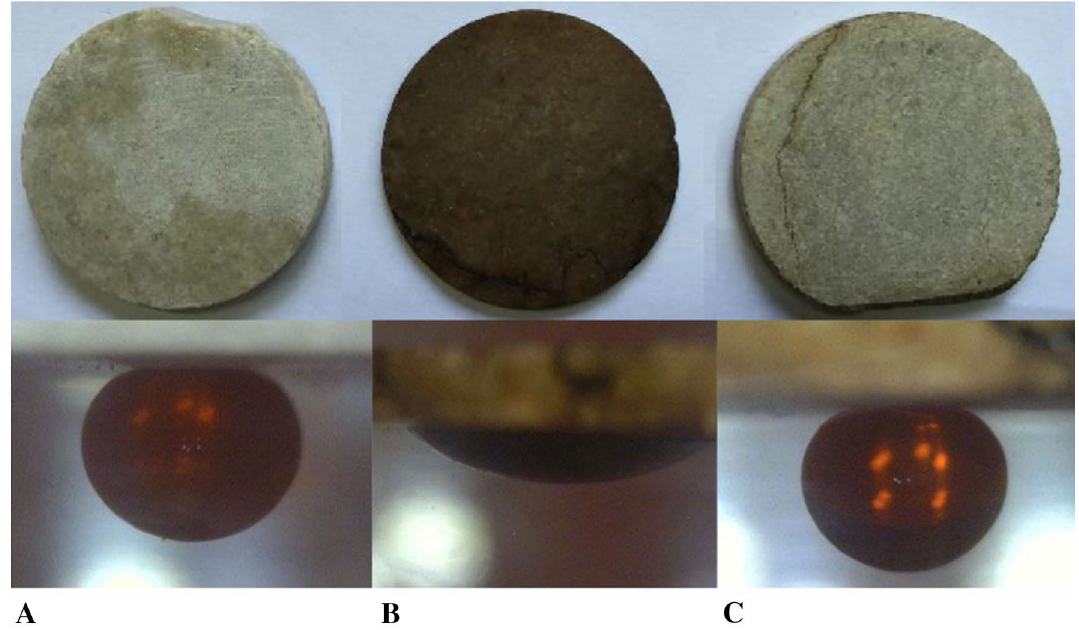
Fig. 5 Effect of MJ03 strain cells on a calcite slice; a untreated surface, b after aging and c after treatment by active MJ02 and MJ04